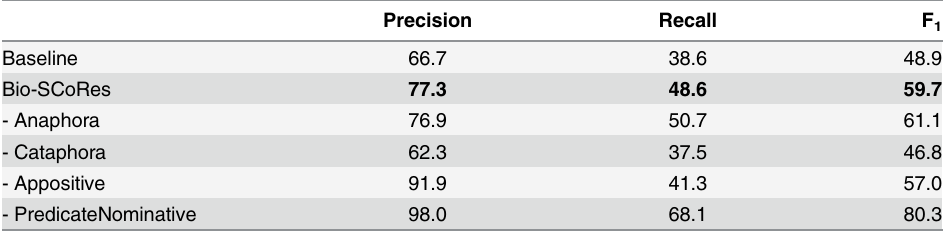
Table 10. Evaluation results on the test portion of SPL coreference dataset using gold coreferential